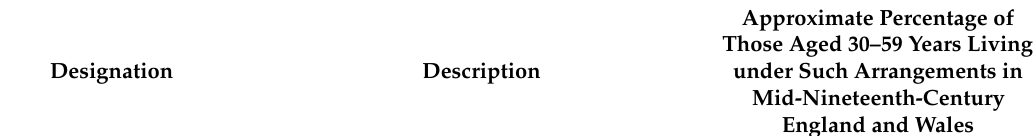
Table 1. Categorisation of the household living arrangements used in this